Question: Describe this figure in one sentence.
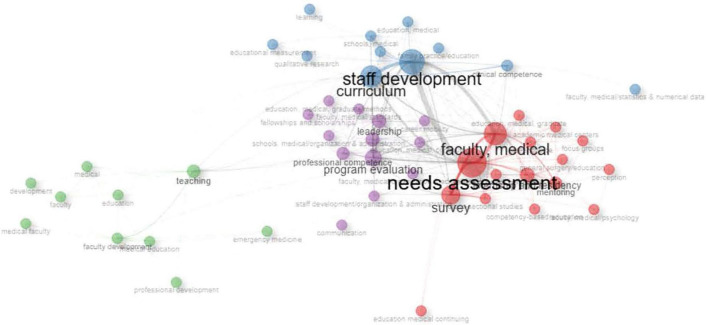
Answer: Keyword co-occurrence network. Network visualization of keyword co-occurrence illustrating conceptual relationships among major research topics in faculty development. Node size represents keyword frequency, while links indicate co-occurrence relationships between concepts.